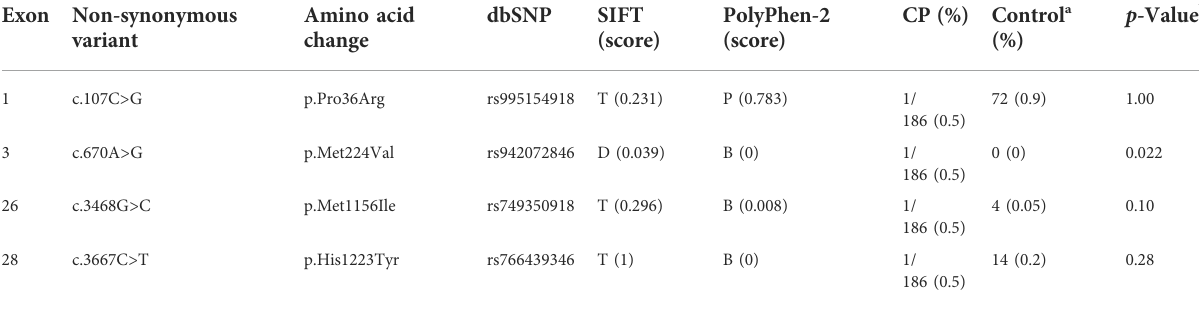
TABLE 1 Non-synonymous CADPS2 variants identi fi ed in Japanese patients with non-alcoholic